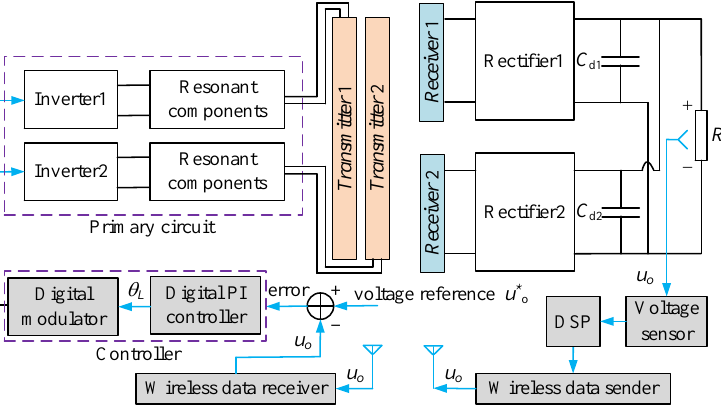
Figure 8. Control diagram of the proposed WPT system.